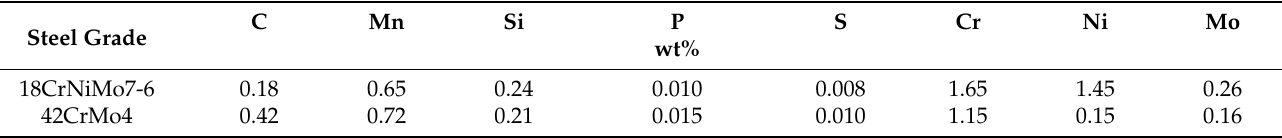
Table 1. The chemical compositions of the analysed